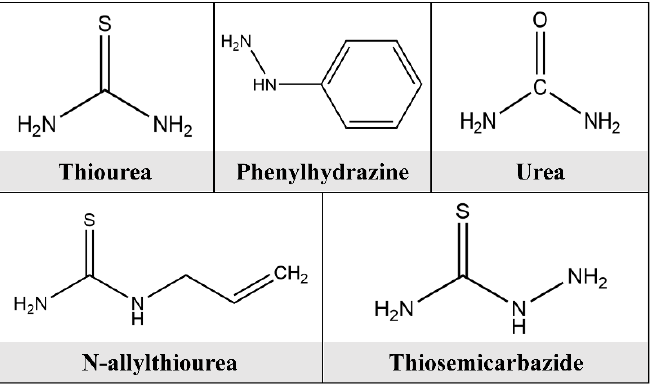
Figure 3. Chemical molecular structures of thiourea, phenylhydrazine, urea, N-allylthiourea, and thiosemicarbazide .